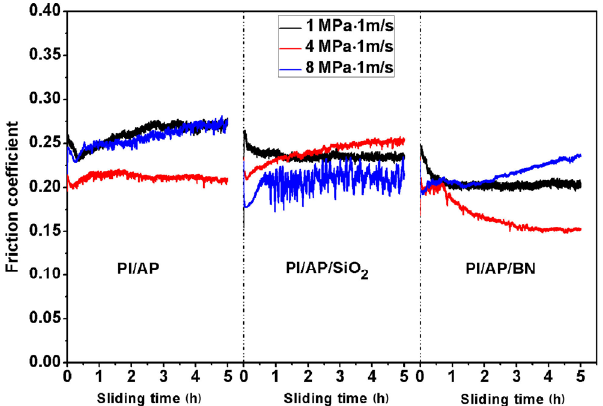
Fig. 6 Evolution of friction coefficient at different sliding time when PI/AP, PI/AP/SiO 2 , and PI/AP/BN slide against Al 2 O 3 at 1, 4, and 8 MPa·1m/s.